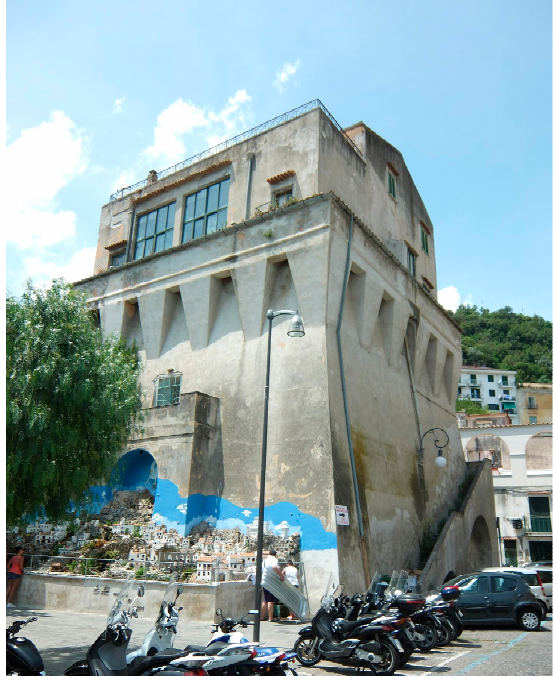
Figure 4. Tower of Marina di Vietri,